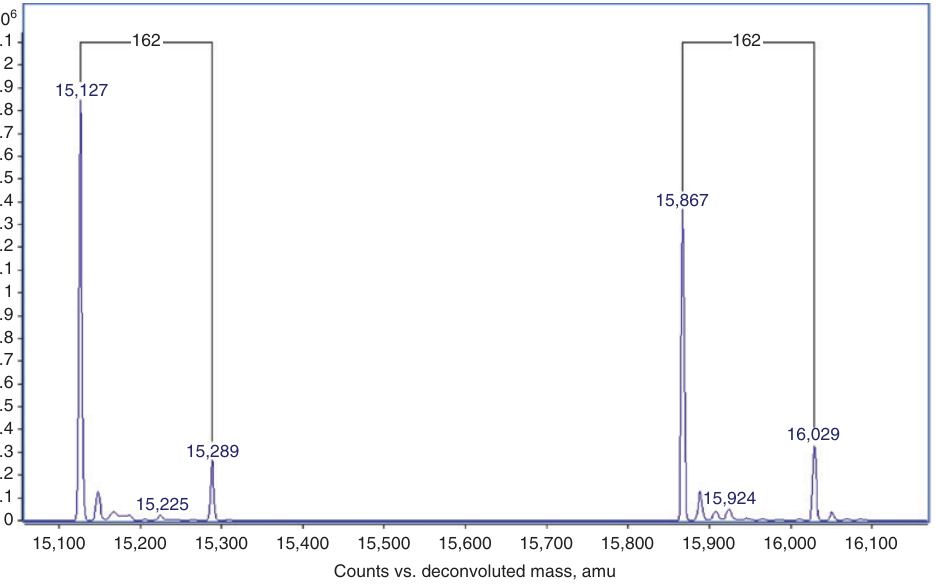
Figure 2: Transformed electrospray mass spectrum of whole lysate showing normal α and β chains at 15,127 and 15,867 Da. Glycation causes a mass increase of 162 Da and the glycated α and β chains are shown at 15,289 and 16,029 Da, respectively.